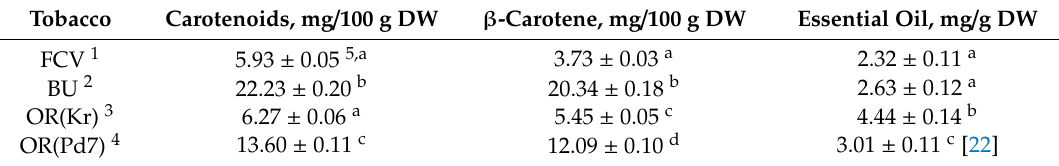
Table 1. Chemical indexes of tobacco leaves.